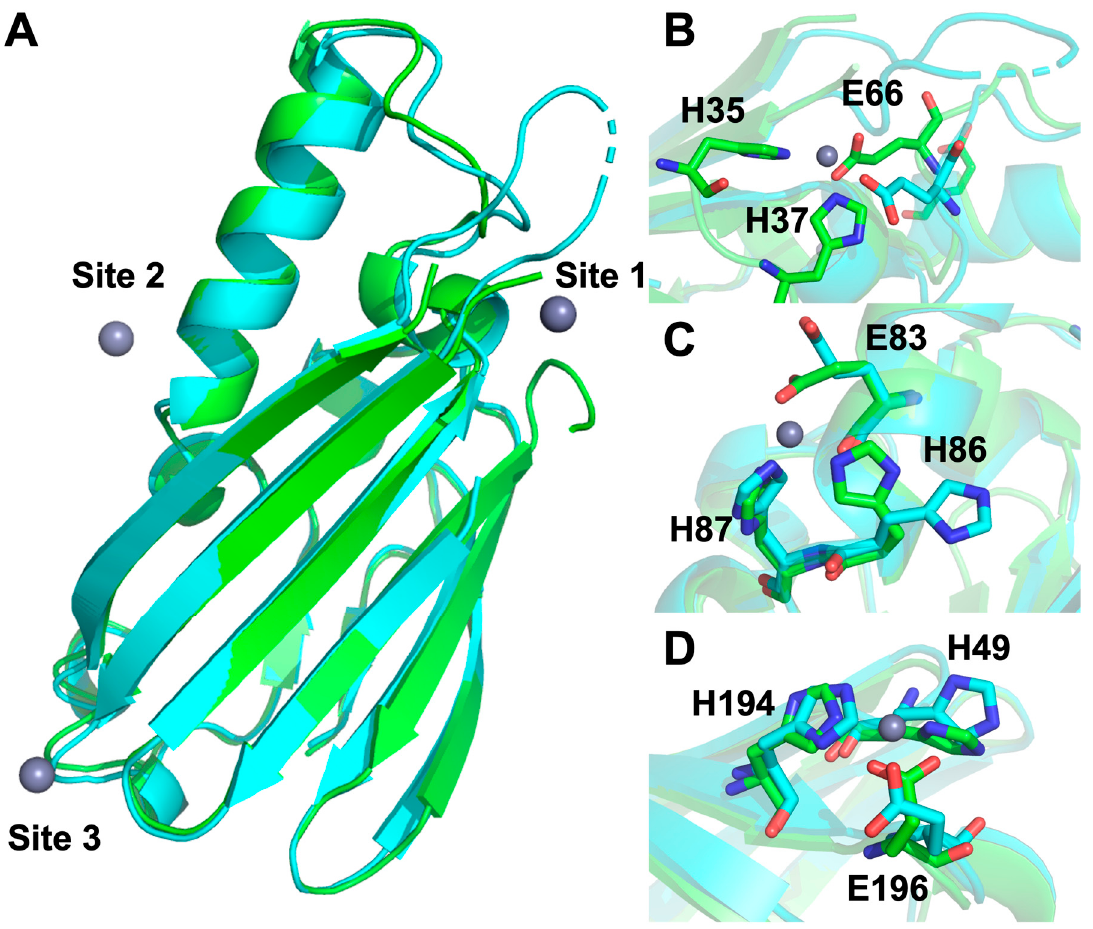
Figure 6. Comparison of zinc-bound (green) and apo (cyan) Δ 124-184 ZrgA. The overall structure ( A ) shown as cartoon and details of zinc binding site 1 ( B ), site 2 ( C ), and site 3 ( D ) with zinc ligands shown as sticks colored according to element. Figure created with Pymol version 2.5.4, Schrödinger, LLC. New York, NY, USA. Table 2. Data collection and refinement statistics for ZrgA crystal structures.